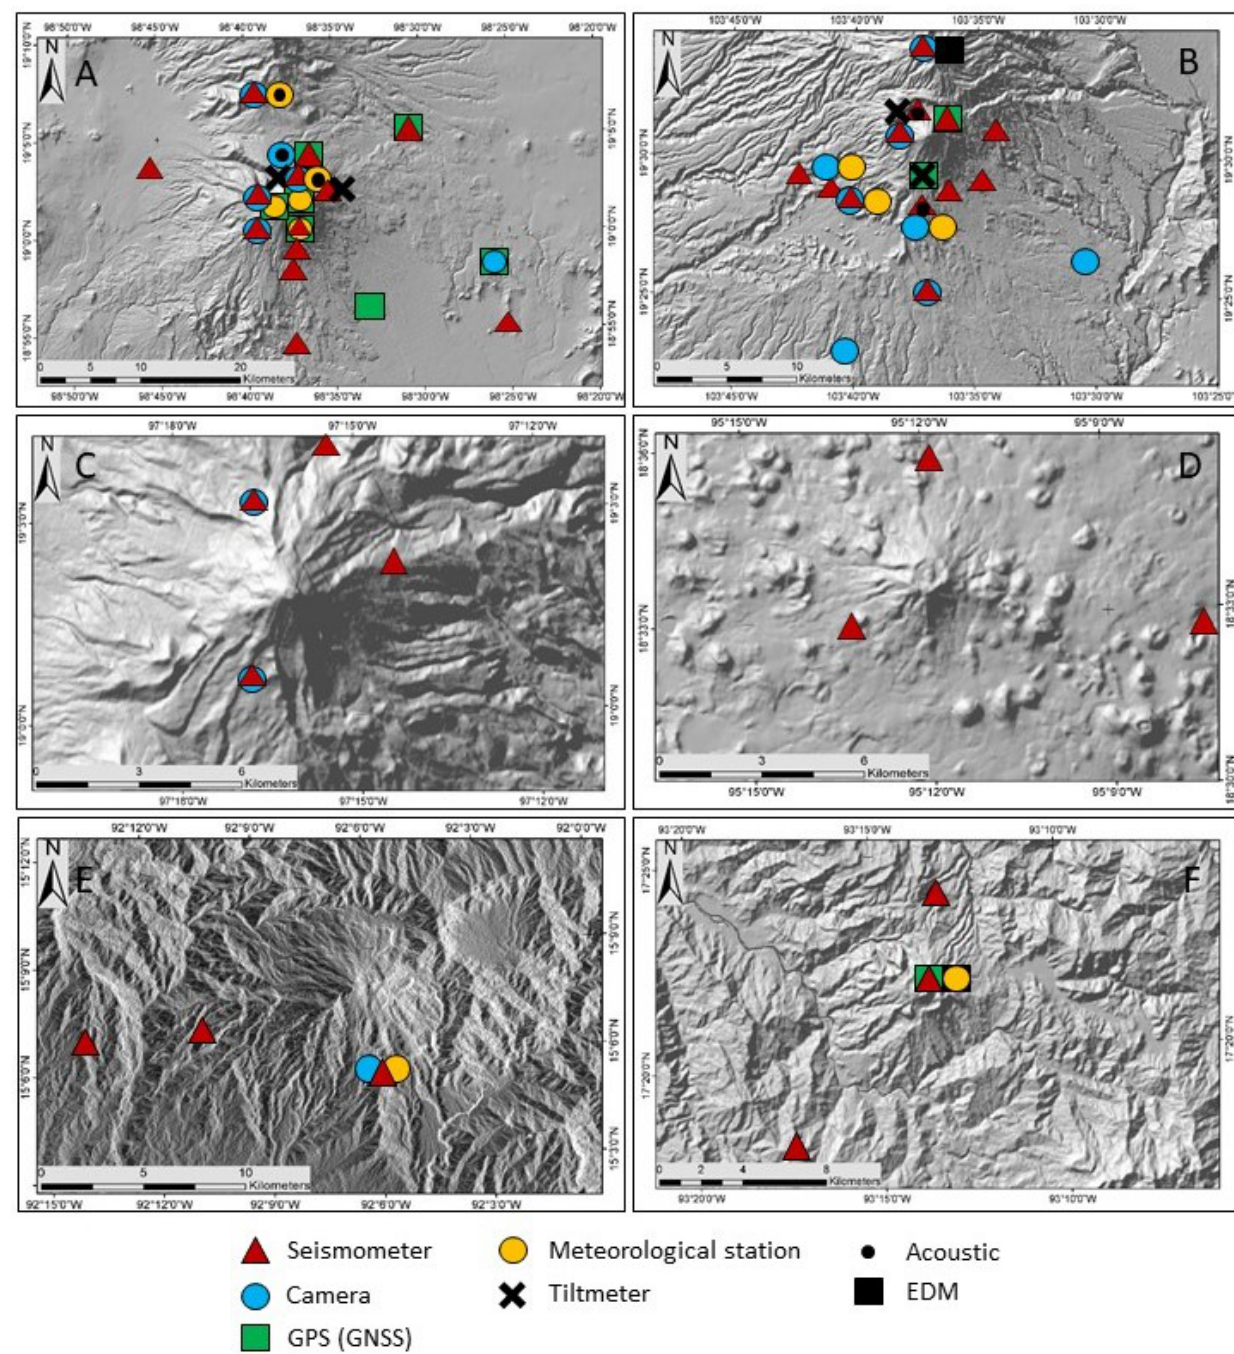
Figure 3: Monitoring stations at each of the main volcanoes monitored in México. [A] Popocatépetl; [B] Colima; [C] Citlaltépetl (Pico de Orizaba); [D] San Martin Tuxtla; [E] Tacaná, and [F] Chichón. Red triangles are seismic stations, while blue triangles are stations with seismic and other monitoring instruments (Acoustic sensor, GPS, tiltmeter, EDM, Camera and/or Meteorological